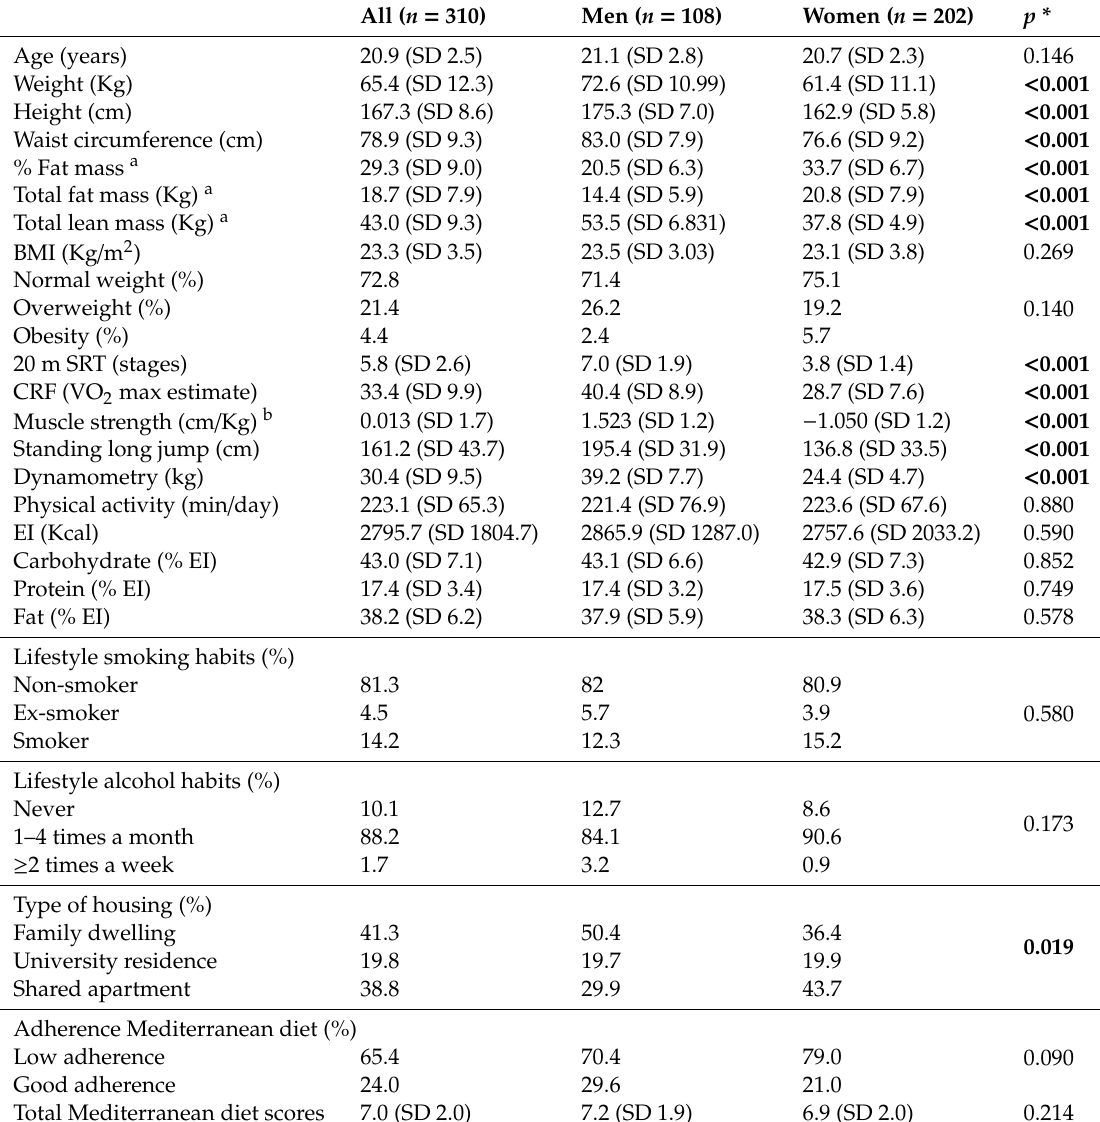
Table 1. Descriptive characteristics of the study sample by